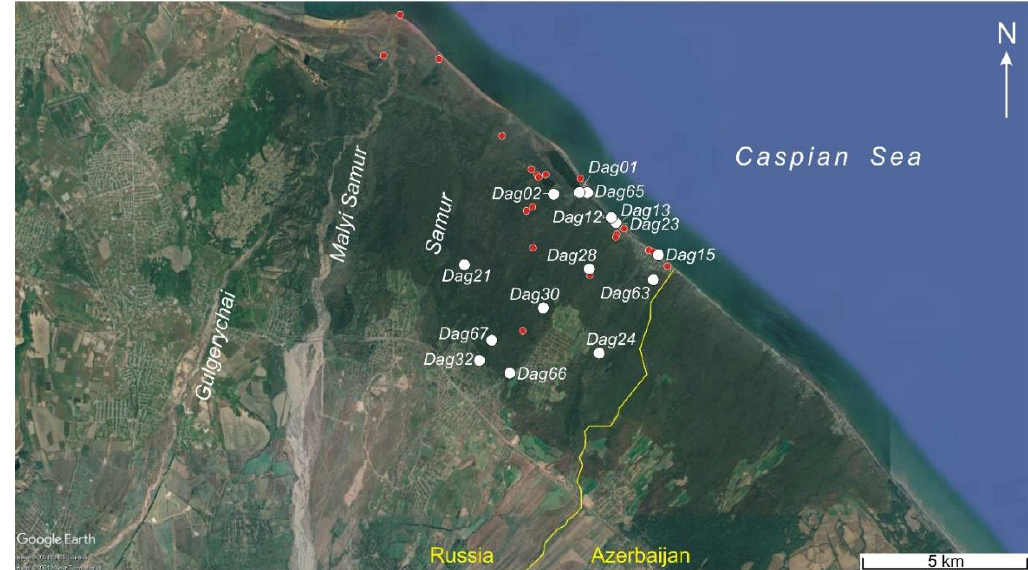
Figure 1. A map of the Ponto-Caspian region, with indication of study area and sampling points of Clathrocaspia . The numbers of localities correspond to those in Table 1. Small red dots show the sampling points where Clathrocaspia have not been found. Table 1. The information of the studied material. The numbers of localities refer to those in the text and figures. Abbreviations: q.—quadrant,